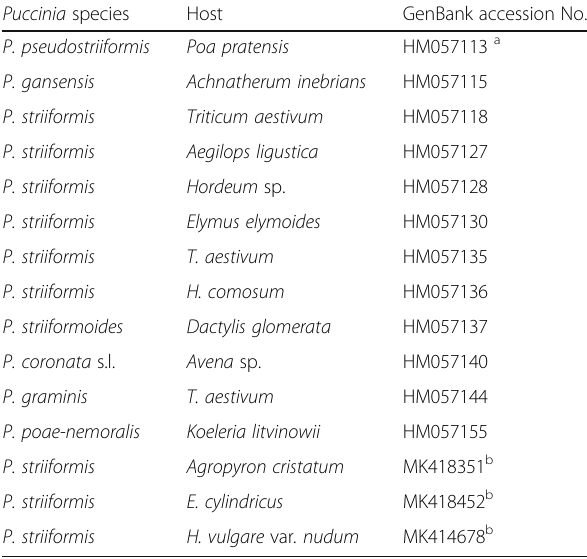
Table 1 List of Puccinia species used in the phylogenetic